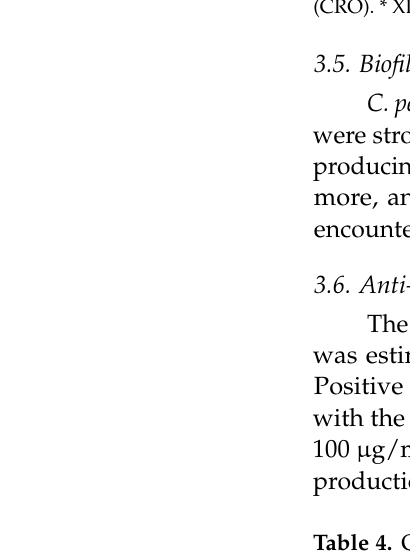
Table 4. Qualitative estimation of color intensity of biofilm formation by tube method in absence and presence of silver nanoparticles (AgNPs) at different concentrations on Clostridium perfringens